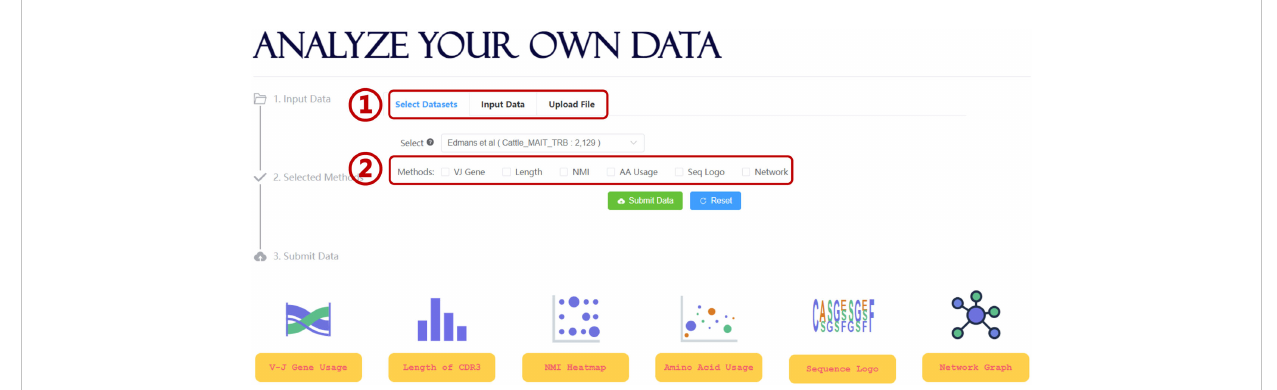
FIGURE 3 Analysis module in UcTCRdb. Screenshot of the search analysis page (1). UcTCRdb allows users to select a speci fi c dataset or upload their data for analysis (2). There are six functions including TCR gene usage, CDR3 length distribution, NMI, amino acid usage, sequence conservation, and similarity network calculation in this module. Users can choose any one or several of them for data analysis.